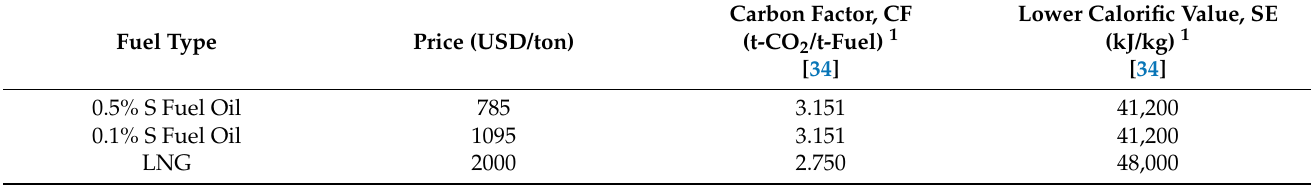
Table 4. Assumed fuel properties: price, carbon factor, and lower calorific value for three different fuels.